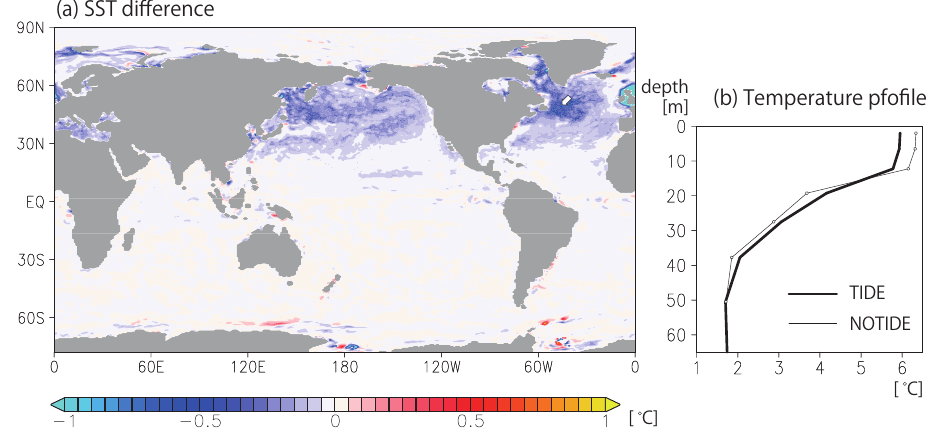
t t Fig. 12. (a) SST difference between TIDE and NOTIDE 1T (C ◦ ). (b) Vertical profiles of temperature T at the site (50 ◦ W, 50 ◦ N) (marked t in (a) ) in TIDE (thick line) and NOTIDE (thin). The vertical range from surface to 65m depth is shown. Both (a) and (b) use 25-hour averages Fig. 12. (a) SST difference between TIDE and NOTIDE ∆ T [C ◦ ]. (b) Vertical profiles of temperature of the end of the 40-day T t at the site (50 ◦ W, 50 ◦ N) (marked in (a)) in TIDE (thick line) and NOTIDE (thin). The vertical range from surface to 65 m depth is shown. Both of (a) and (b) use 25-hour averages of the end of the 40-day experiments.